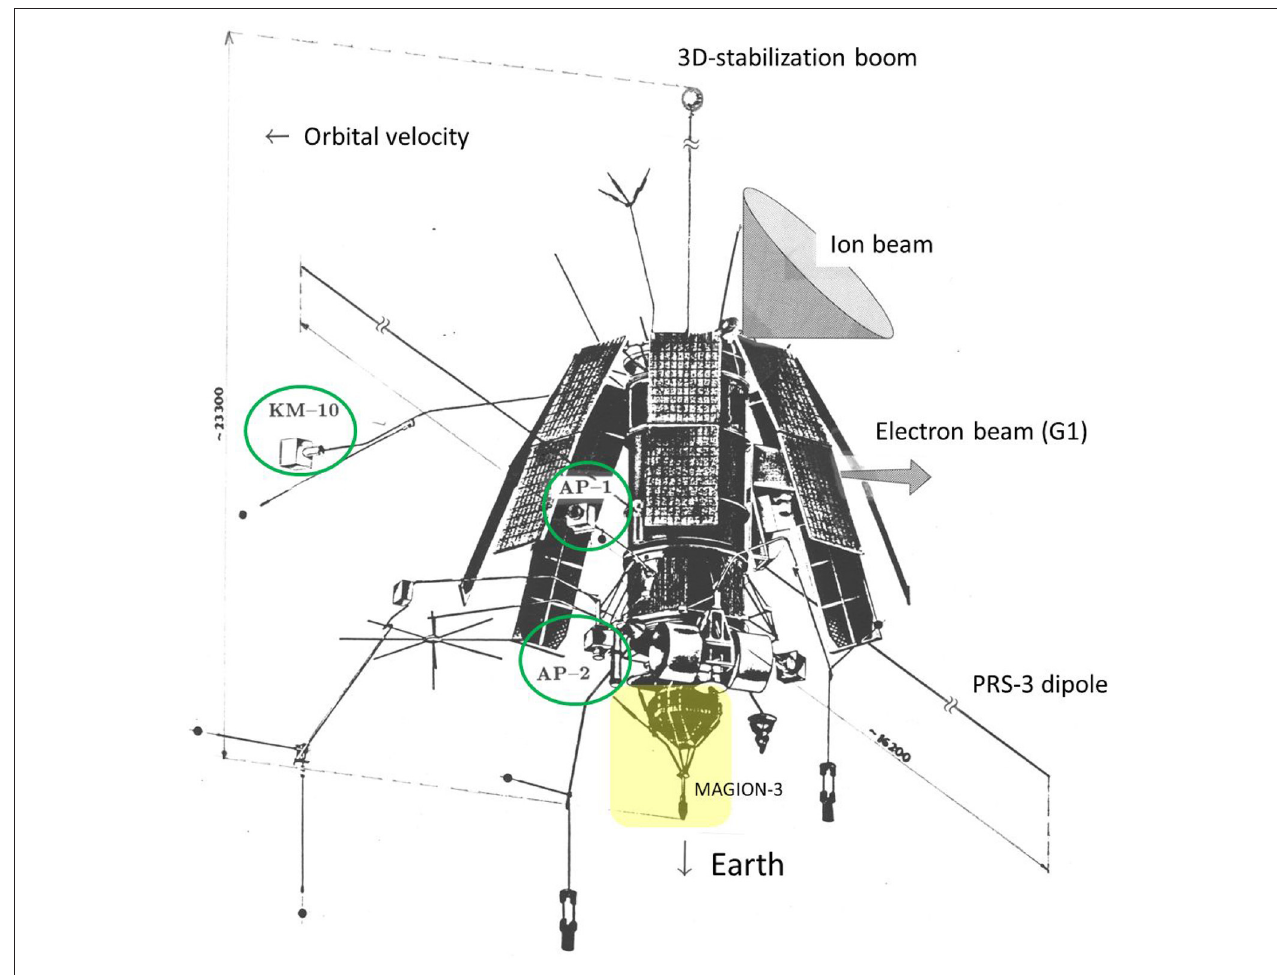
FIGURE 1 | IK–25 deployed (before MAGION–3 separation, its launch position highlighted in yellow). Positions of the KM–10, AP–1, and AP–2 particle sensors, the PRS–3 dipole antenna, and the electron/ion injection directions are indicated. (Adapted from Prech, 1995).